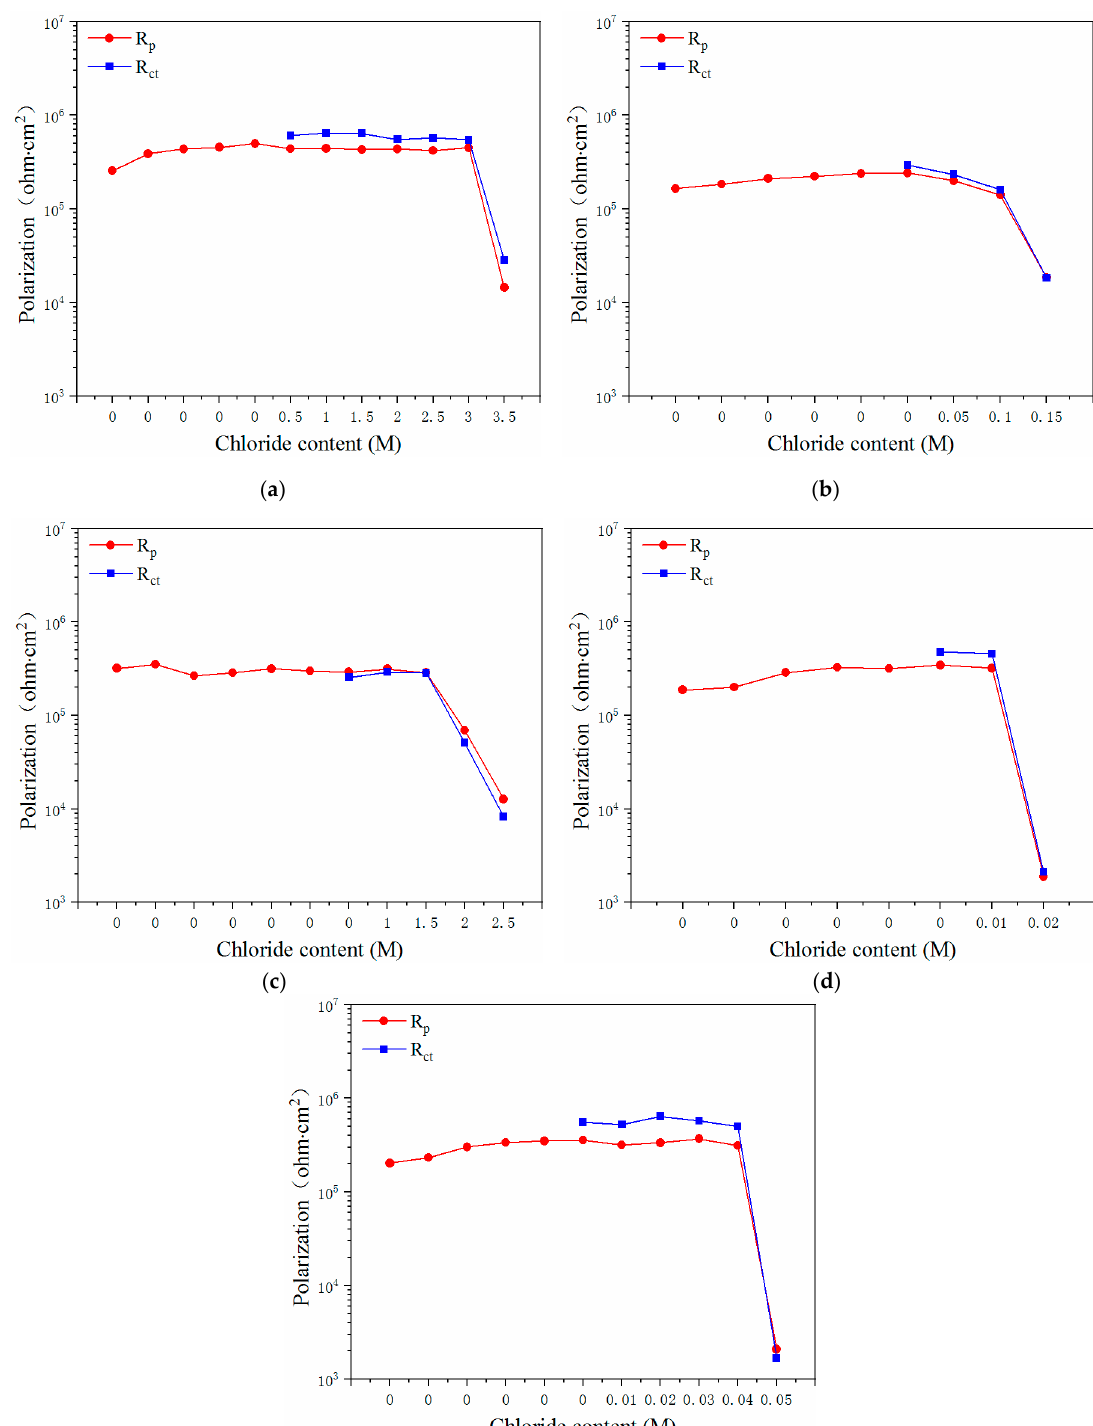
Figure 8. Influence of chloride content on the icorr and CR values of the steels: ( a ) novel type-2205 duplex stainless steel; ( b ) type-2205 duplex stainless steel ( c ) type-316 austenitic stainless steel; ( d ) HRB400; ( e ) HRB500.